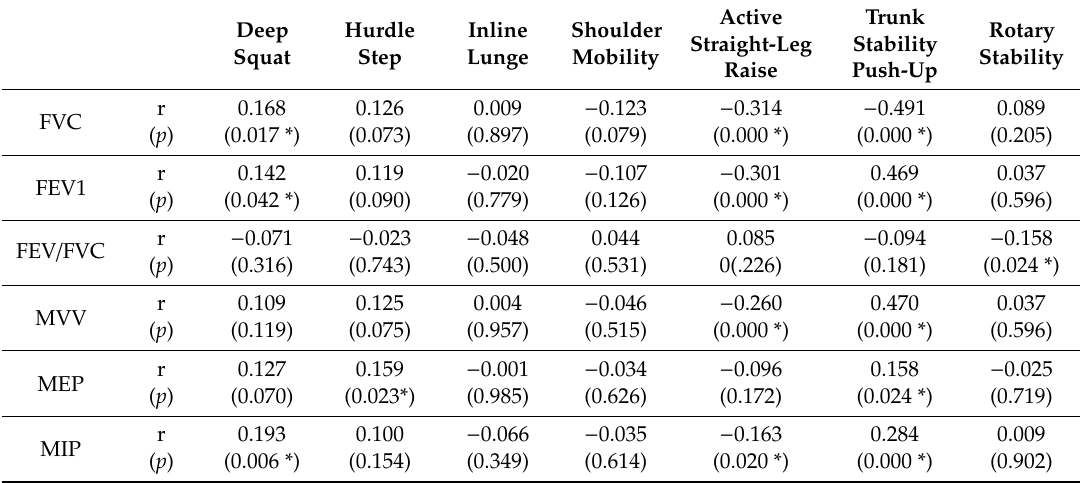
Trunk Rotary Stability Stability Push-Up